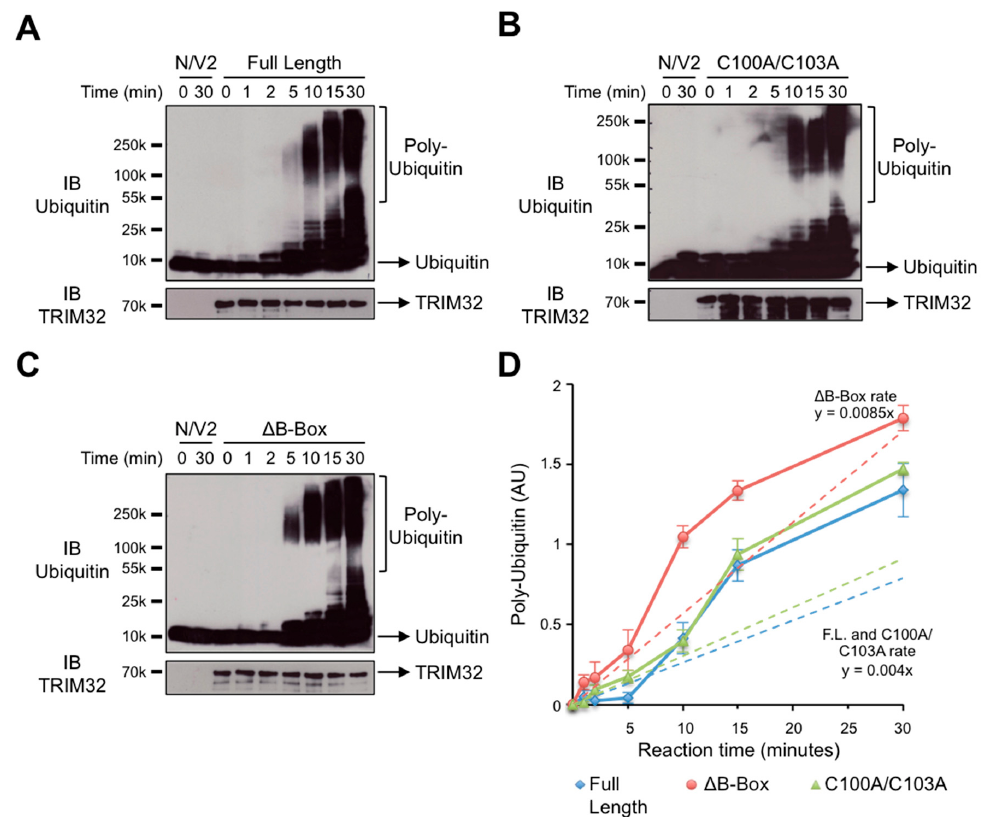
Figure 3. Deletion of the TRIM32 B-box domain affects the rate of poly-ubiquitin chain formation. Comparable amounts of full-length TRIM32 ( A ), C100A/C103A ( B ) or Δ B-box ( C ) mutants were used in an in vitro ubiquitination reaction with the UbE2N/V2-conjugating enzymes. Samples were taken at the indicated time points and proteins were resolved by SDS-PAGE. Poly-ubiquitin chains were detected by anti-ubiquitin immunoblot (top panels) followed by stripping and reprobing of the membrane with anti-TRIM32 antibody (bottom panels). ( D ) Poly-ubiquitin chains were quantified, normalized to the amount of E3 used in the assay and plotted (solid lines). The observed reaction rate was calculated and plotted (dashed lines). Equations showing the calculated reaction rate for each construct are shown. Average and standard error of five independent experiments are